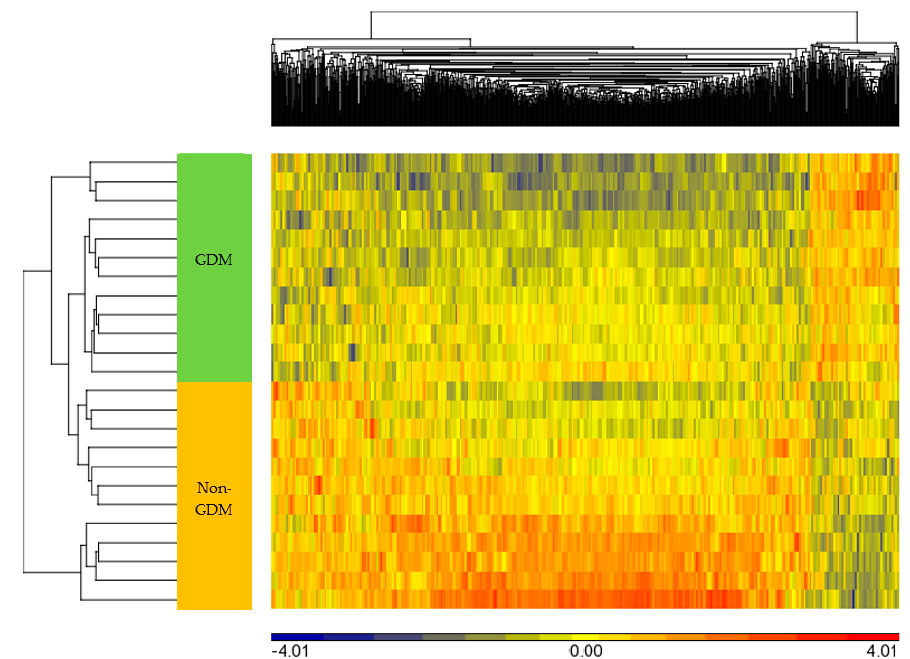
Figure 4. Heatmap showing methylation signatures of 1046 CpG sites in women with/without GDM. DNA methylation across 1046 CpG sites in each sample was analyzed using Euclidean distance for both rows (observations) and columns (features) and average linkage criteria. Samples are shown in rows and are clustered in GDM (green) and non-GDM (orange) groups. Standardized M-values are depicted using a blue (hypomethylation in GDM) to red (hypermethylation in GDM) methylation gradient. Of the 1046 di ff erentially methylated CpG loci, 148 CpG sites (14.2%) were